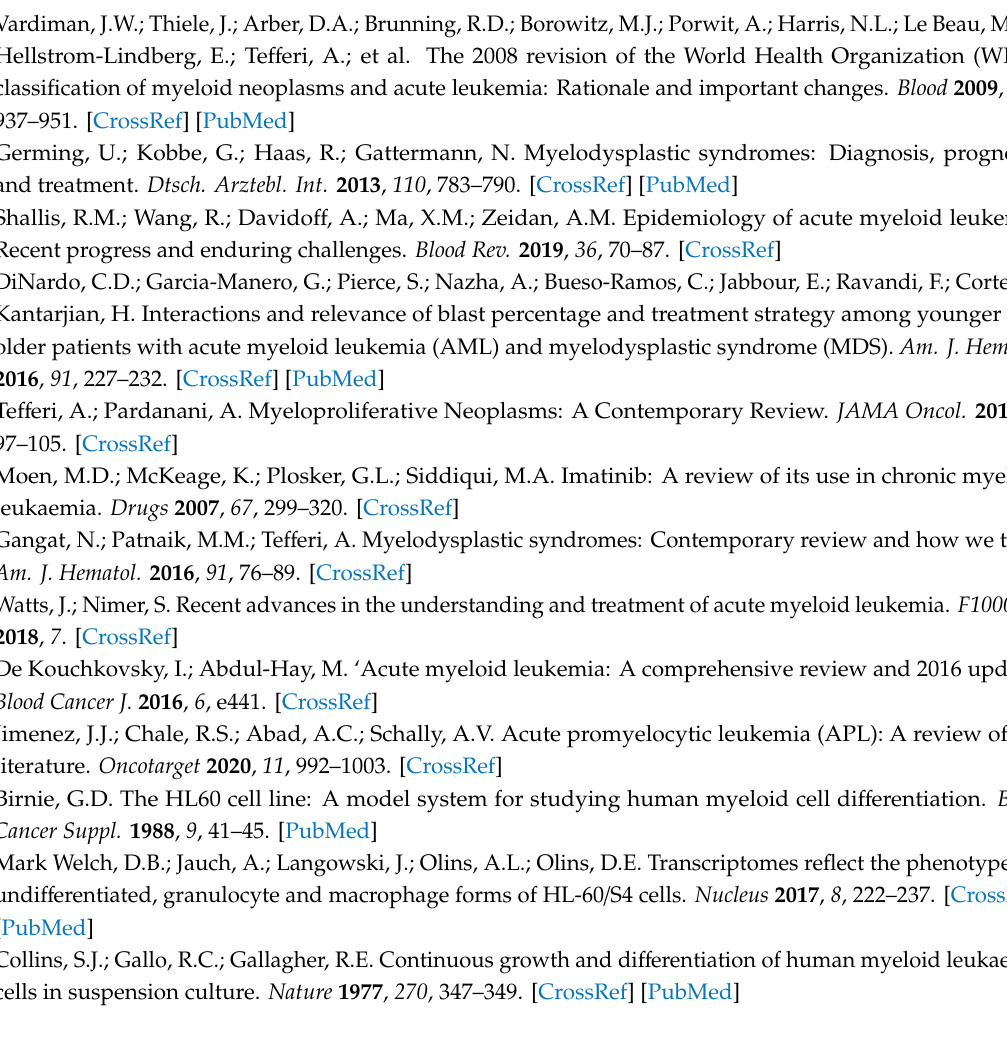
DU325 treatment, Figure S11: The CD11b +/ Ly6G + granulocytic myeloid-derived suppressor cells are sensitive to DU325